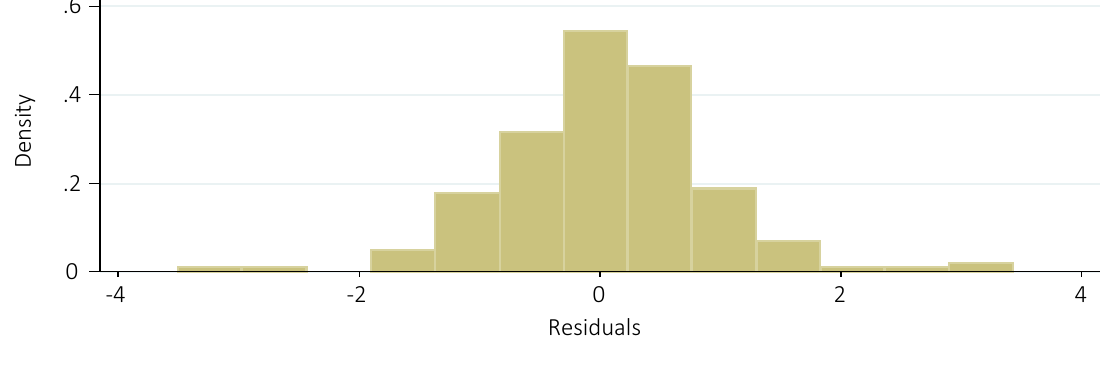
Figure 1. High-risk